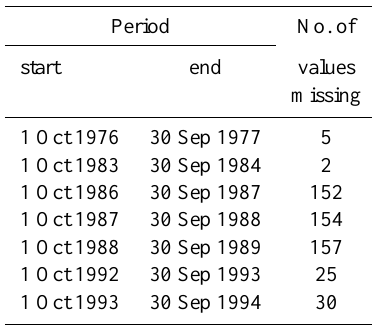
Table 3. Number of missing values of daily rainfall measurements at station C (Moira).